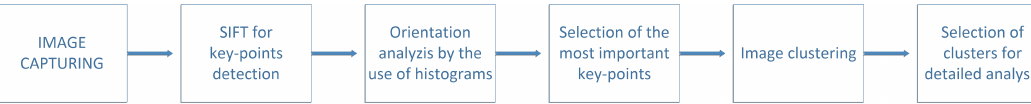
Figure 4. The processing of input image goes through the following stages first to locate the key-points over the image and after to select among them the most important ones which will be clustered and forwarded to the detection stage in the form of a blurred nevi